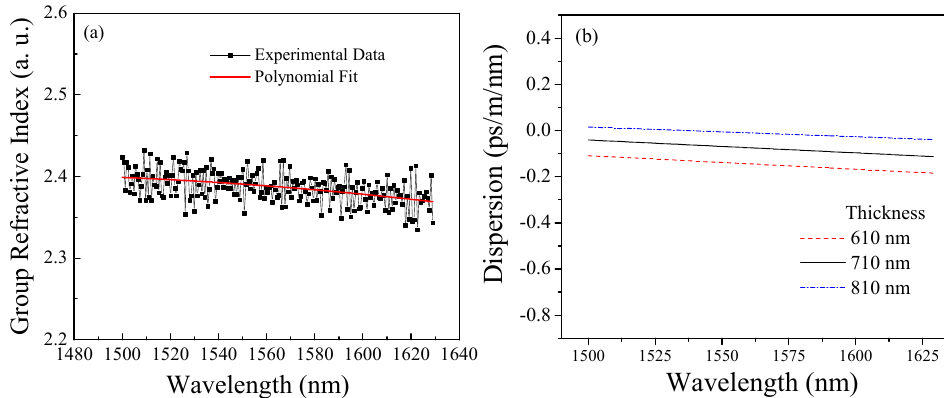
Figure 7. ( a ) The calculated group refractive index, and ( b ) dispersion of the silicon nitride micro- ring resonator.